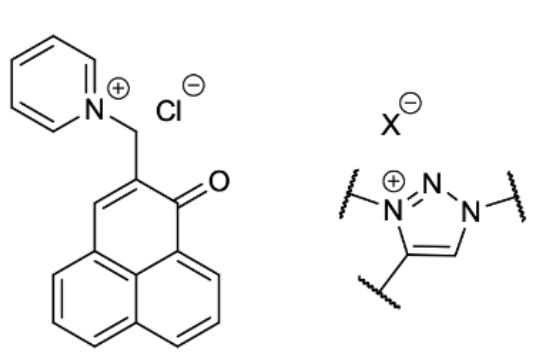
Figure 1. Structure of SAPyR (left) and 1,3,4-trisubstituted-1,2,3-triazolium salt